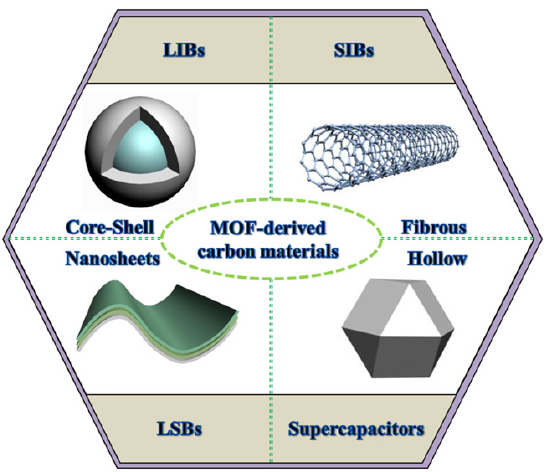
Figure 10. MOF-derived carbon materials for energy storage applications [64]. Reproduced with permission.